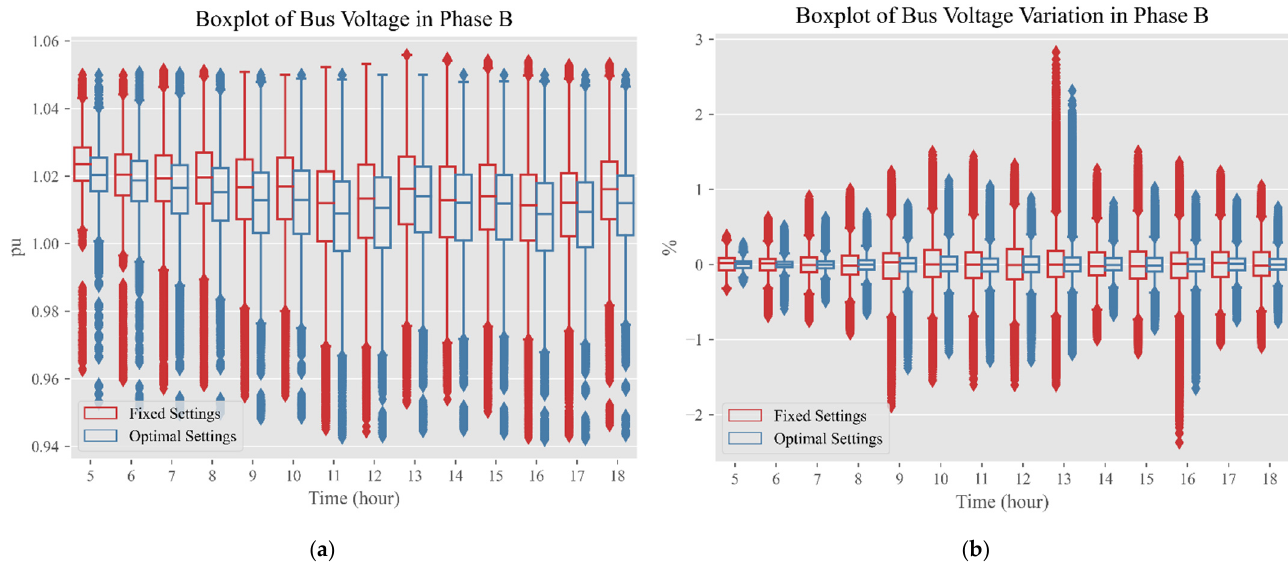
Figure 9. Boxplots of ( a ) bus voltage and ( b ) voltage variation in phase B for each hour with fixed and optimal volt-var control settings.